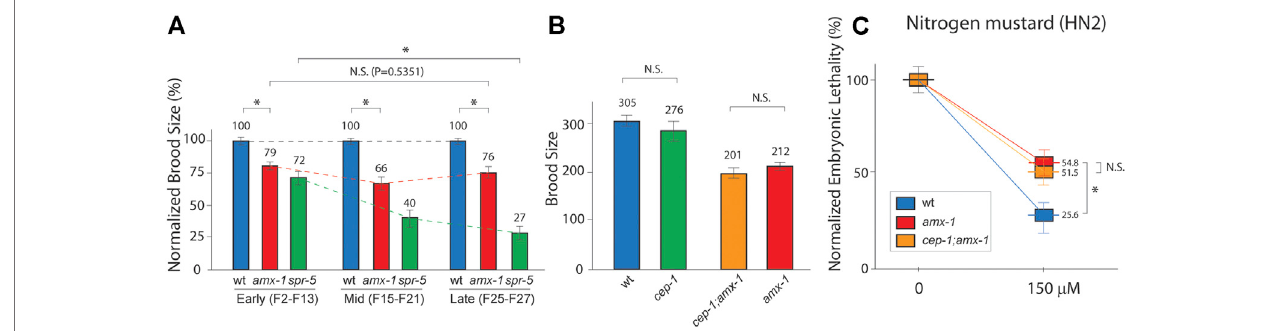
FIGURE 1 | AMX-1 is necessary for proper fertility but not for transgenerational fertility defects. (A) Brood size is scored among the progenies of indicated genotypes. amx-1 mutants exhibit the reduced brood size compared to wild type in early [F2-F13, p < 0.0001), mid (F15-F21), p < 0.0001) or late generations(F25-27), p < 0.0001]. However, no obvious transgenerational decline was observed between early and late generations of amx-1 mutants (dashed lines, p = 0.5351 in early vs. lategenerationsof amx-1 and p =0.0022inearlyvs.lategenerationsof spr-5 . p =0.1807forwtand cep-1,p =0.2770for amx-1 and cep-1;amx-1 . (B) Broodsize comparison between indicated genotypes. (C) Relative hatching of wild type, amx-1 and cep-1;amx-1 mutants after treatment with the indicated dose of nitrogen mustard (HN2). Asterisk indicates statistical signi fi cance. Error bars represent standard errors of the mean. n > 24 for each genotype. N.S. indicates no statistical signi fi cance. p values calculated by the two-tailed Man-Whitney test, 95%